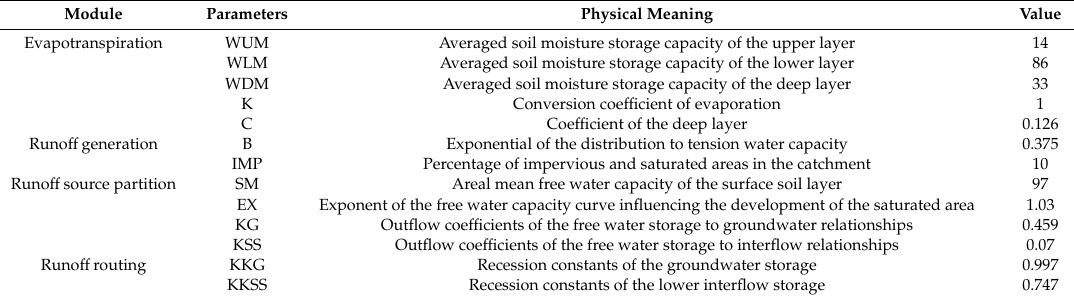
Table 3. The parameters of XAJ.